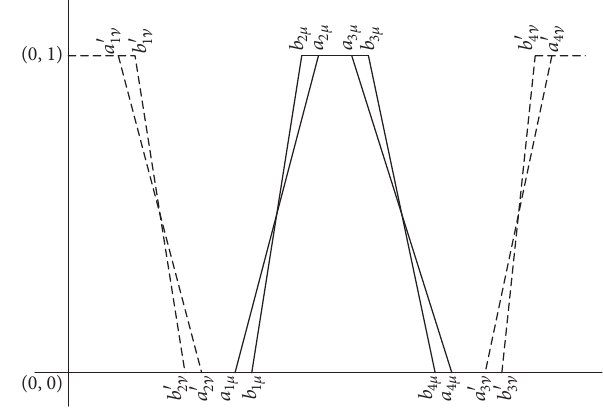
Figure 6: Pictorial representation of Example